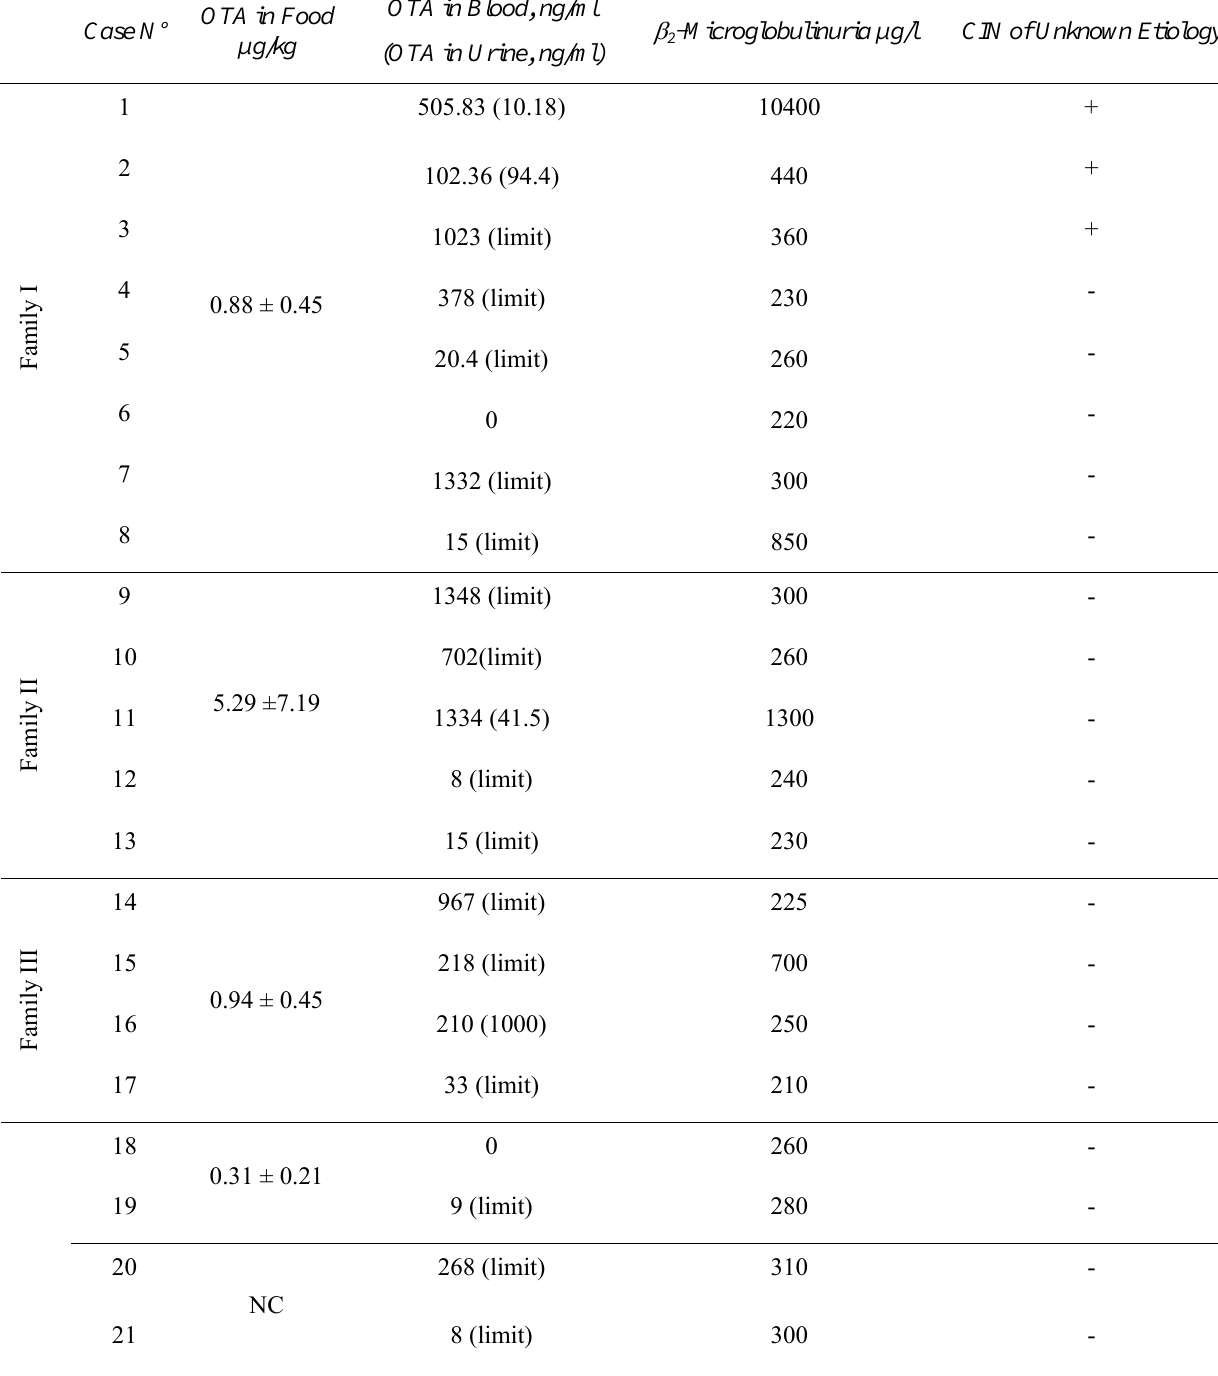
-microglobulinuria. 2